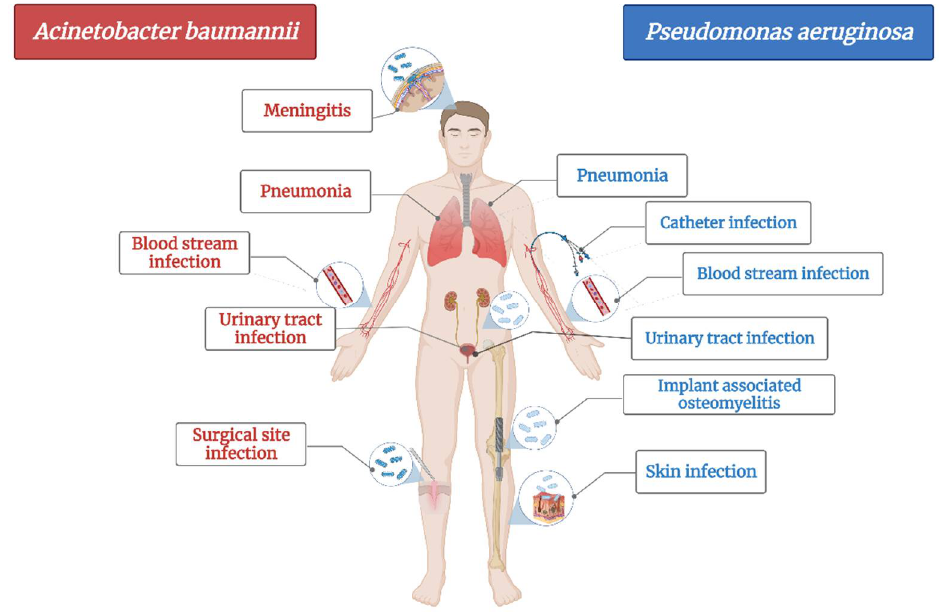
Figure 1. The main diseases induced by Acinetobacter baumannii and Pseudomonas aeruginosa . Among “ESKAPE” pathogens ( E. faecium , S. aureus , K. pneumoniae , A. baumanni , P. aeruginosa and E. cloacae ), A. baumannii has been classified as being one of the most severe bacteria in terms of antimicrobial resistance (considered nowadays to be multidrug-re- sistant (MDR), extensively drug-resistant (XDR), and even pandrug-resistant strain (PDR)) as it shows resistance for almost all first-line antibiotics used for healthcare asso- ciated infections (problem that has emerged since the late ’70s)